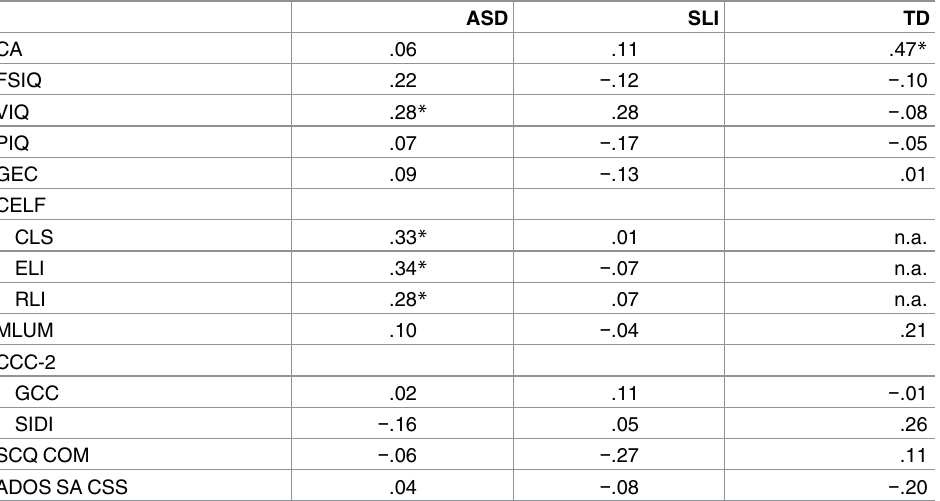
Table 9. Results for exploratory analysis of cued (versus non-cued) content mazes. ASD SLI TD CA .06 .11 .47 * FSIQ .22 − .12 − .10 VIQ .28 * .28 − .08 PIQ .07 − .17 − .05 GEC .09 − .13 .01 CELF CLS .33 * .01 n.a. ELI .34 * − .07 n.a. RLI .28 * .07 n.a. MLUM .10 − .04 .21 CCC-2 GCC .02 .11 − .01 SIDI − .16 .05 .26 SCQ COM − .06 − .27 .11 ADOS SA CSS .04 − .08 − .20 Associations between per-child cued (versus non-cued) content maze use and age, intellectual ability, executive function, language, and social ability, as measured by Kendall’s τ b . Children in the TD group did not complete the CELF. CA = chronological age in years; FSIQ = full-scale IQ; VIQ = verbal IQ; PIQ = performance IQ; GEC = BRIEF global executive composite; CLS = CELF core language score; ELI = CELF expressive language index; RLI = CELF receptive language index; MLUM = mean length of utterance in morphemes; GCC = CCC-2 general communication composite; SIDI = CCC-2 social-interaction deviance index; SCQ COM = SCQ; ADOS SA CSS = ADOS-G social affect calibrated severity score; * = statistically significant at P = .05 after correction for false discovery rate